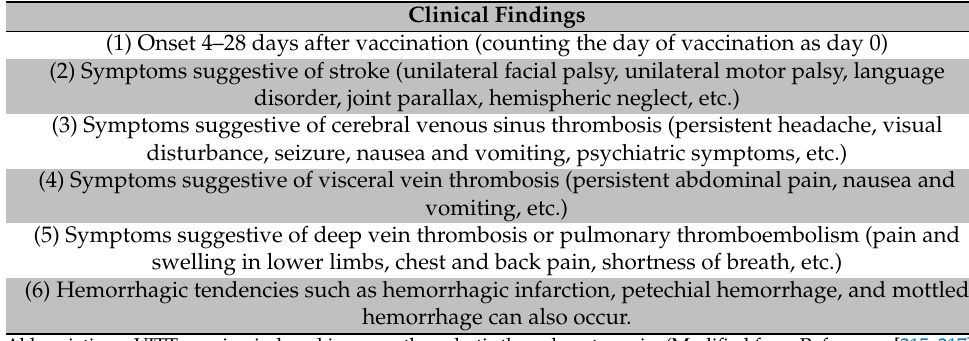
Figure 3. Mechanism of VITT development in adenovirus vector vaccines. Immunoglobulin G autoantibodies against the complex of platelet factor 4 and free DNA in the vaccine result in platelet activation and aggregation. In addition, the release of microparticles and activation of coagulation by vascular endothelial cells are thought to be mechanisms underlying thrombus formation in VITT. Table 4. Clinical features indicative of VITT. Clinical